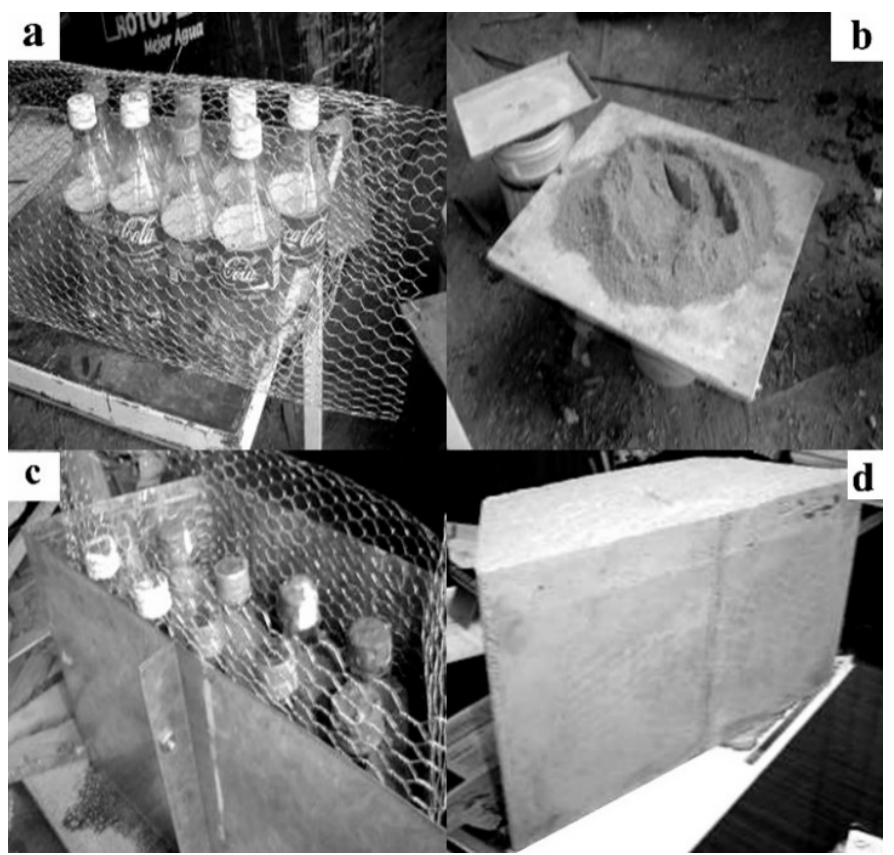
Figure 2. The process of preparation of a PET/net/concrete-based block: ( a ) Two PET bottle arrays moored with a galvanized mesh; ( b ) mortar preparation; ( c ) PET bottle distribution in two rows; ( d ) molded piece with a trapezoidal shape.